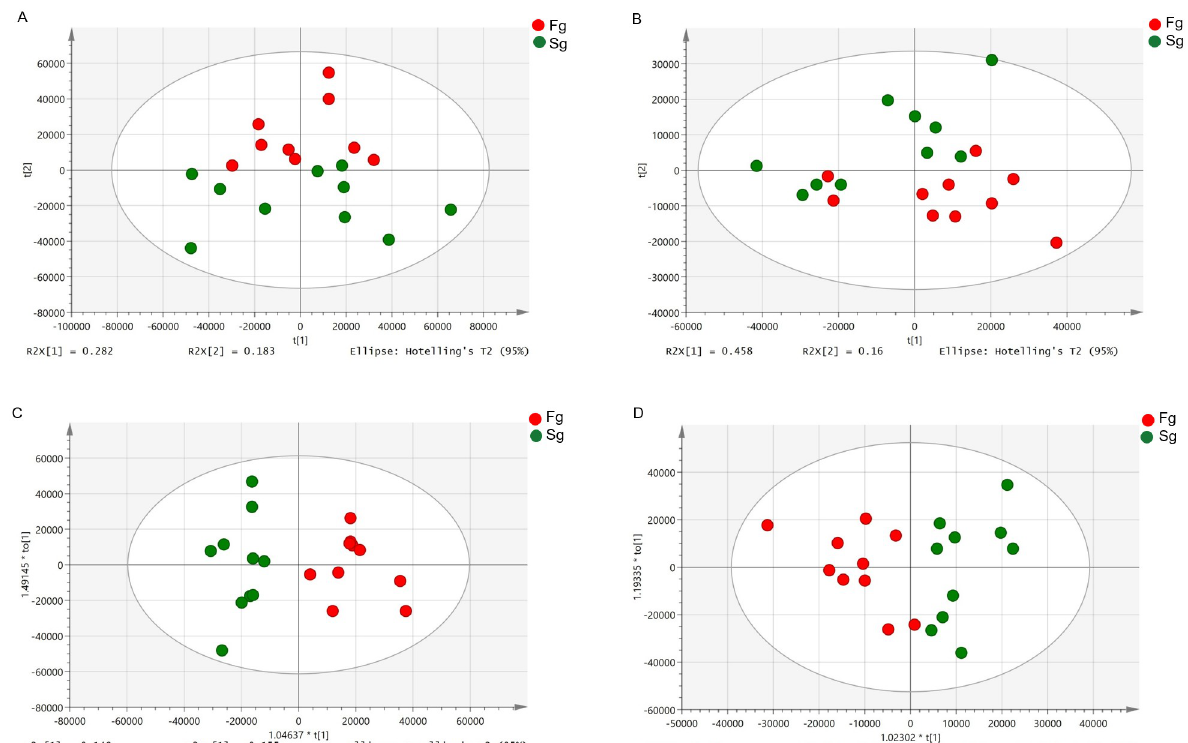
Fig 1. PCA (A and B, in positive and negative modes, respectively) and OPLS-DA (C and D, positive and negative modes, respectively) scores plots based on LC-MS/MS data of hepatopancreas samples from Fg (red) and Sg (green).